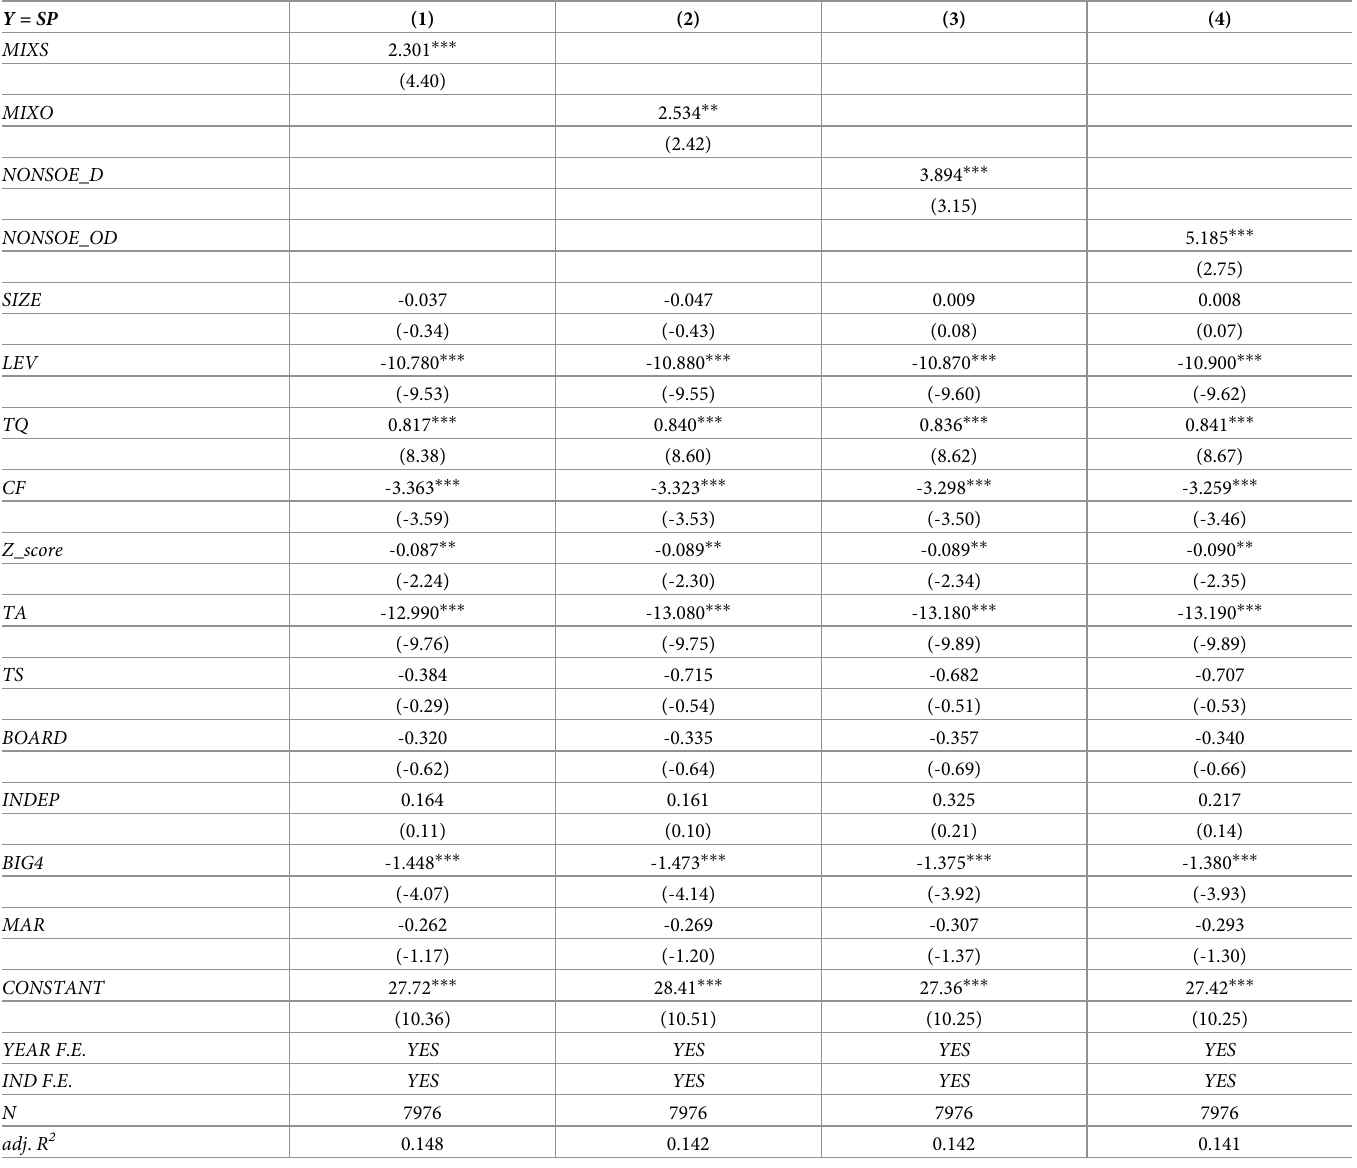
Table 3. The impact of mixed-ownership reform on the strategy choice of